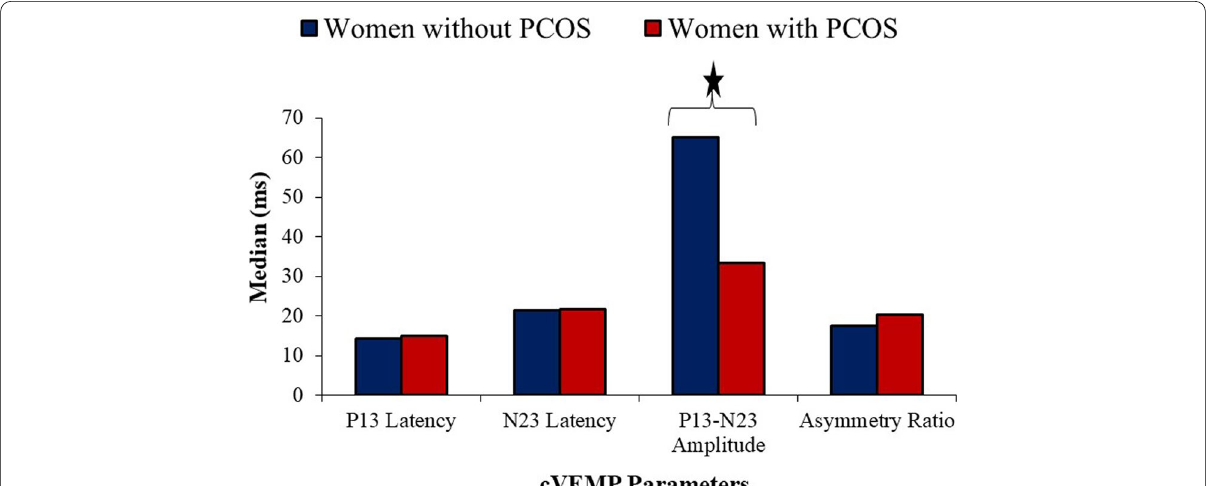
Fig. 4 The median value of P13 and N23 latencies, peak-to-peak amplitude, and asymmetry ratio obtained from women with and without PCOS